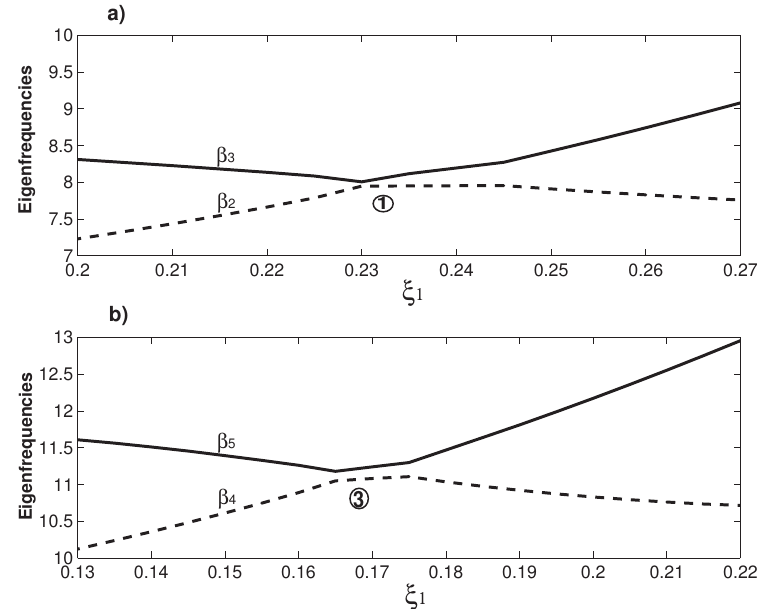
Figure 3. ( a ) A closer look at the veering of β 2 / β 3 around ξ 1 = 0.23, which is marked as the No. 1 veering locus in Figure 2; and ( b ) a closer look at the veering of β 4 / β 5 around ξ 1 = 0.17, which is marked as the No. 2 veering locus in Figure